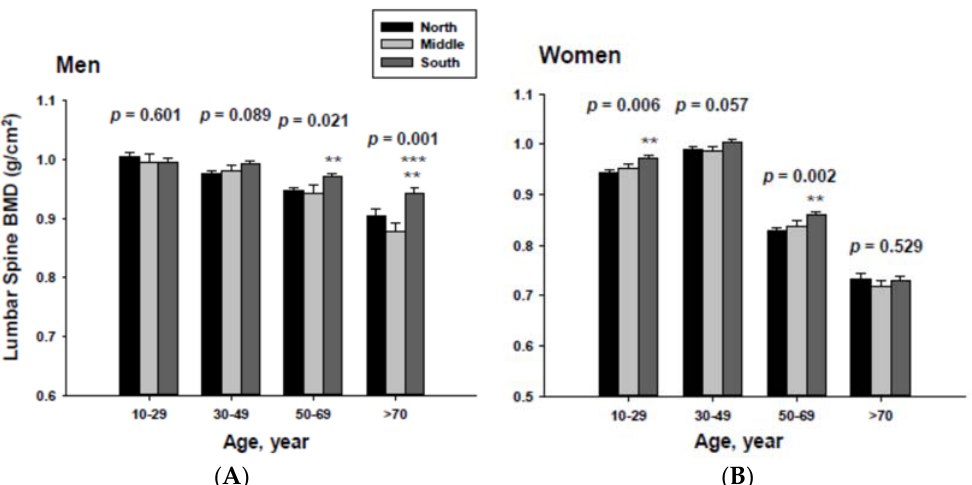
Figure 4. Adjusted lumbar spine bone mineral densities according to age and geographic location in men ( A ) and women ( B ).The p values are p for trend in the same group from ANCOVA test adjusted for total body fat, smoking, job, alcohol intake, moderate activity and education for men, and for total body fat, smoking, job, alcohol intake, moderate activity, education, menopause, oral contraceptive use and hormone replacement therapy for women. Subject numbers for men are 10–29 years old, 832, 151, 591; 30–49 years old, 1296, 267, 985; 50–69 years old, 976, 286, 902; ≥ 70 years old, 325, 120, 333 for North, Middle and South, respectively, and for women are 10–29 years old, 806, 192, 556; 30–49 years old, 1358, 255, 1017; 50–69 years old, 714, 248, 785; ≥ 70 years old, 304, 131, 413 for North, Middle and South, respectively. ** p < 0.05, North vs. South; *** p < 0.05 Middle vs. South.